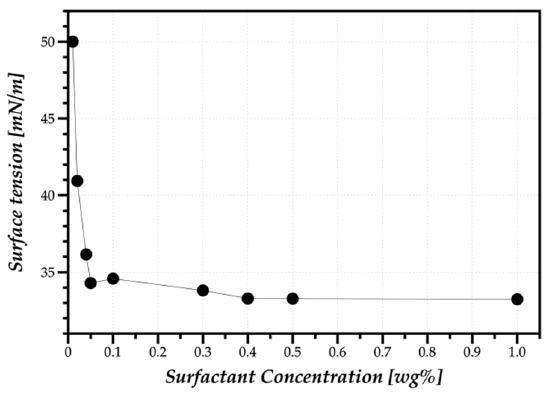
Figure 2. Variation of surface tension as a function of the surfactant concentration.